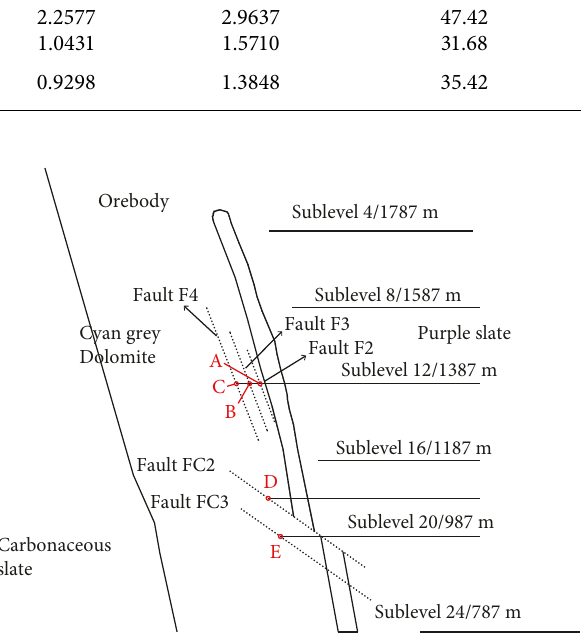
Figure 6: Schematic diagram of fault monitoring point